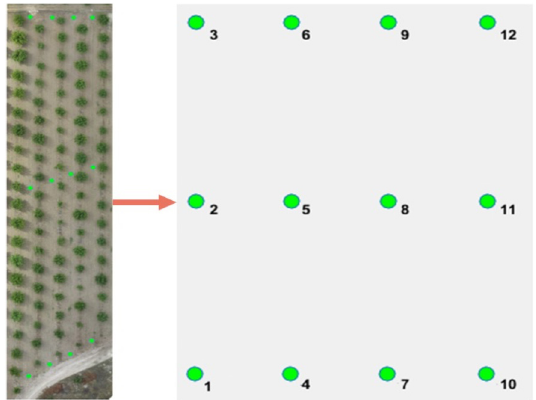
Figure 10. Agri-field map to topological grid representation (the enumerated nodes denote the upper, middle, and lower points that define navigation tracks).